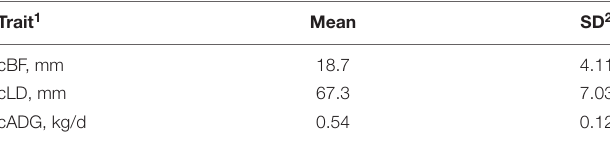
TABLE 1 | Descriptive statistics for the traits used in the study ( n = 126,052). Trait